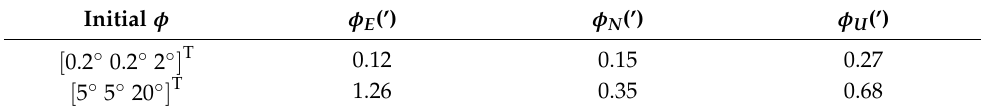
° ° ° . Figure 11. The error curves of φ in the cases of the initial misalignment angles [ 5 ◦ 5 ◦ 20 ◦ ] T .